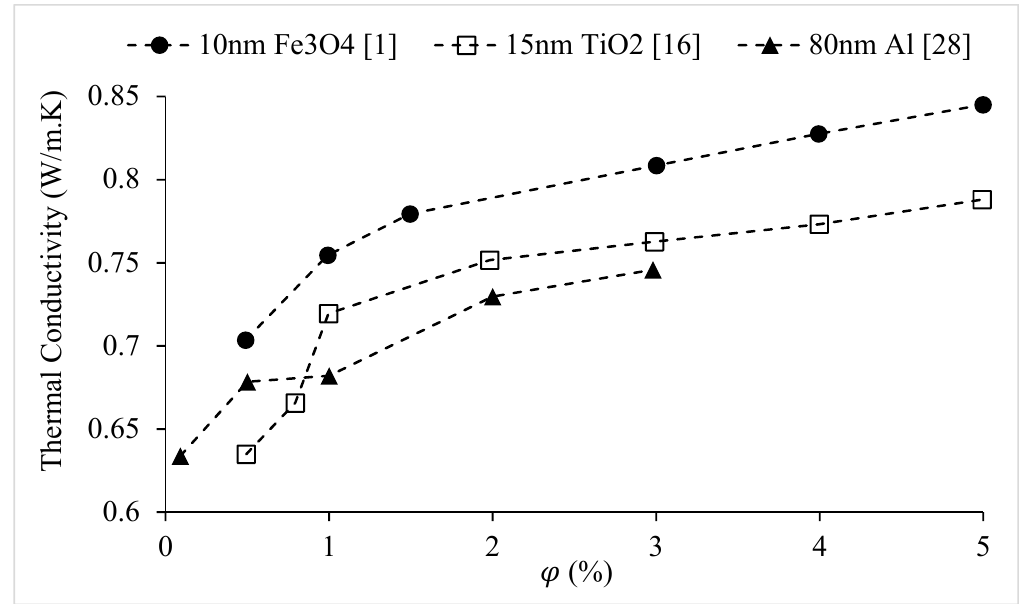
Figure 18. Variation of thermal conductivity of TiO 2 –water nanofluid at nanoparticle volume concentrations of 𝜑 = 1%, 1.5%, and 2% , as a function of temperature, °C.